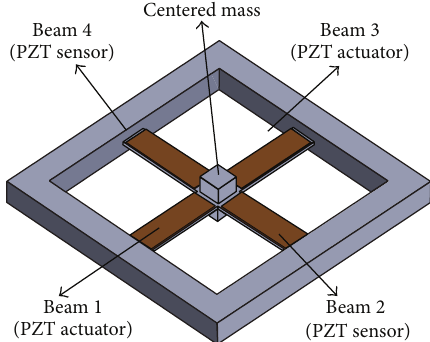
Figure 4: Schematic of a rocking-mass gyroscope Ansari et al. [79].